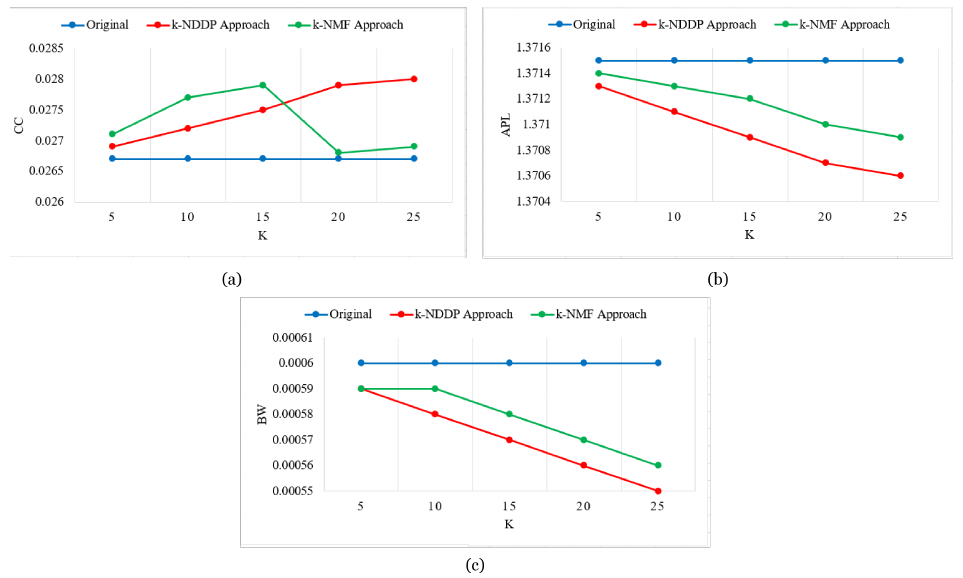
Figure 8. Comparison of k -NDDP with k -NMF(SOCFB-USFCA72). ( a ) CC; ( b ) APL; ( c ) BW.